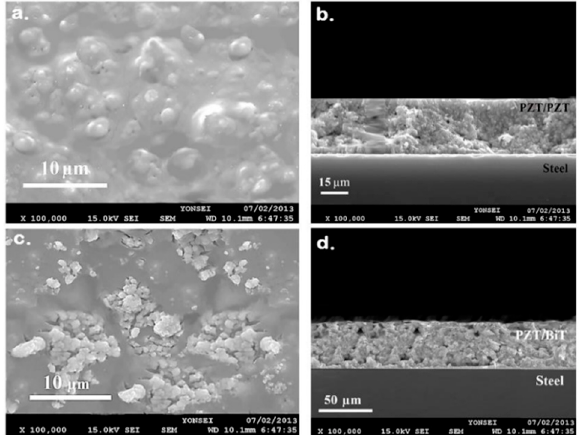
Figure 5. SEM images captured from hybrid thick films of type 5[C + 2S] ( a , b ) PZT/PZT of 30 µm thickness, and ( c , d ) PZT/BiT of 50 µm thickness.